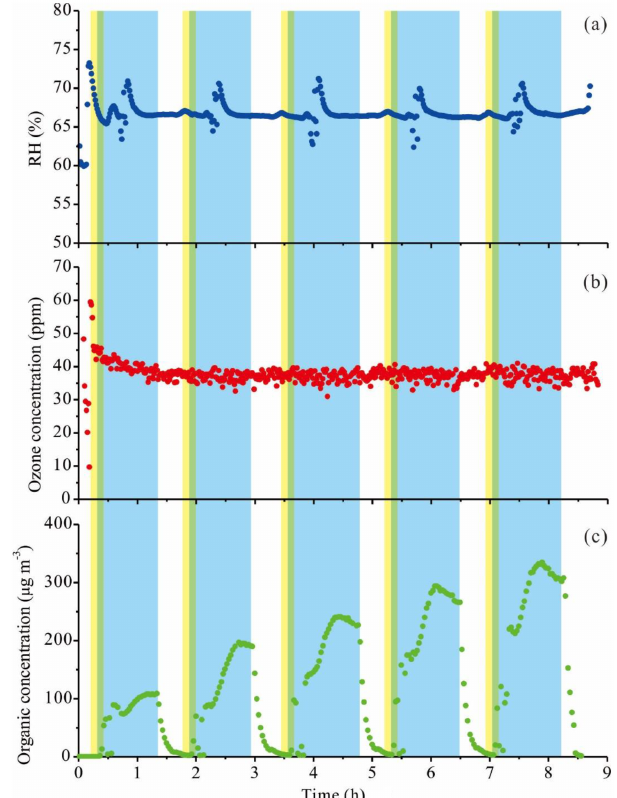
Figure 3. Time series of (a) relative humidity (RH), (b) ozone and (c) organic concentrations during the aging of gas-phase emissions from heated peanut oil. The yellow and light-blue regions represent the heating oil and OH exposure period, respectively. The green re- gion is the overlap between heating oil and OH exposure